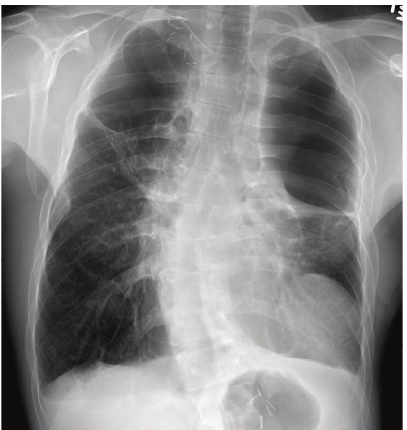
Figure 2: PA chest X-ray taken in July 2013 shows mass lesion at the level of left cardiophrenic recess and biapical large bullae.